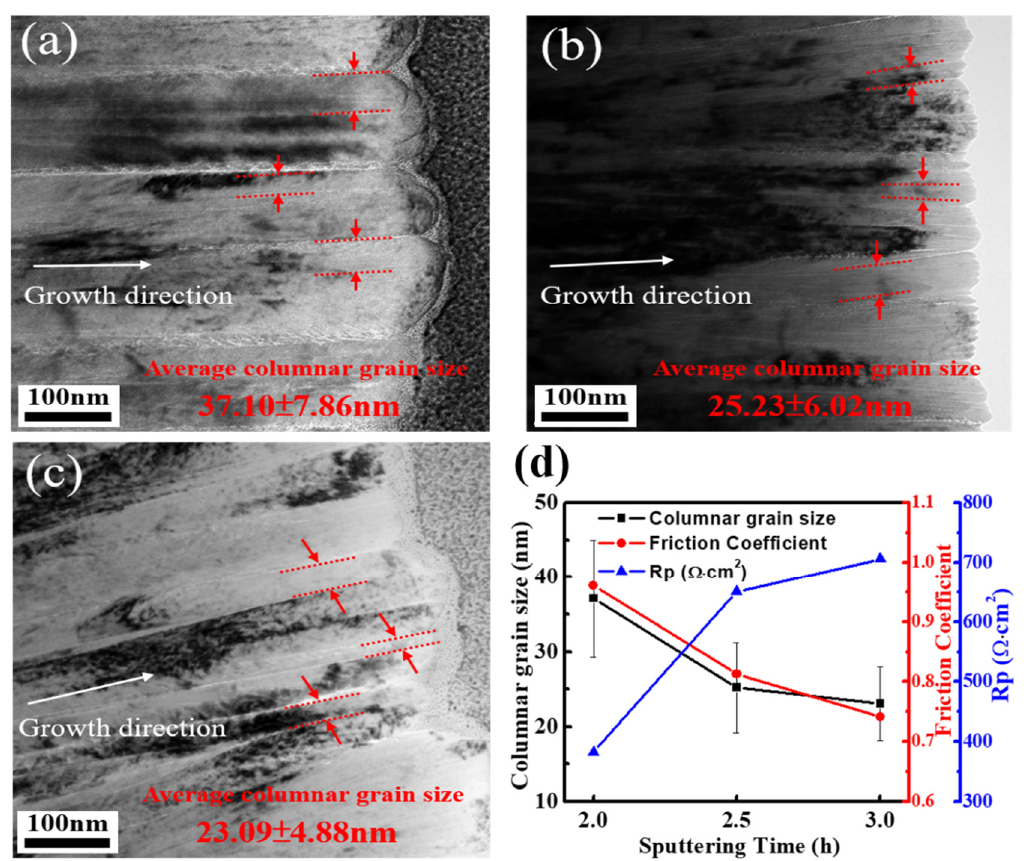
Figure 12. TEM image of CrN thin films deposited of ( a ) 2 h, ( b ) 2.5 h, ( c ) 3 h, and ( d ) plot for co- lumnar grain size, Friction Coefficient and Hardness, and Polarization resistance of CrN films with different coating